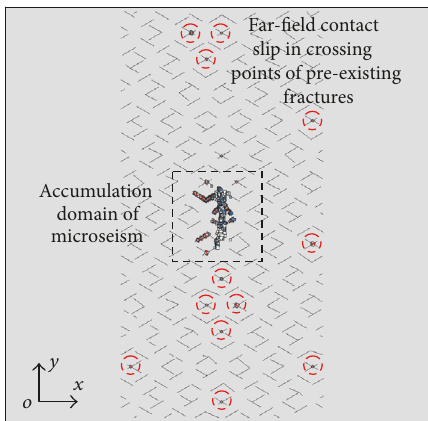
Figure 15: Distribution of final damaged events and contact slip events by microseismic analysis in global domain in naturally fractured